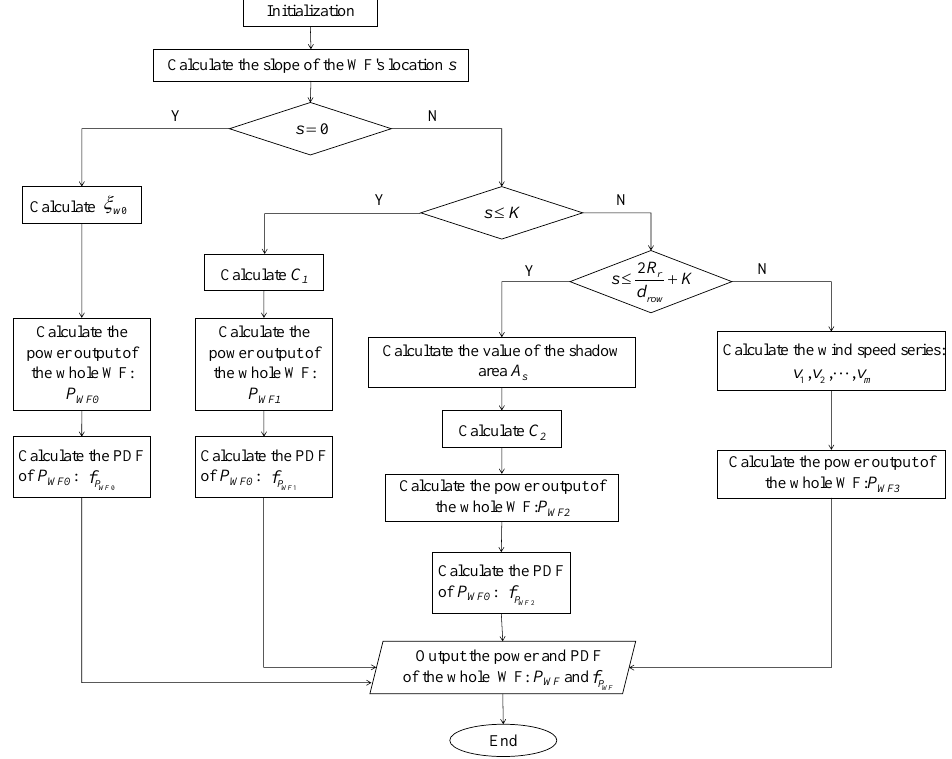
Figure 8. Flowchart of the implementation of the power calculation